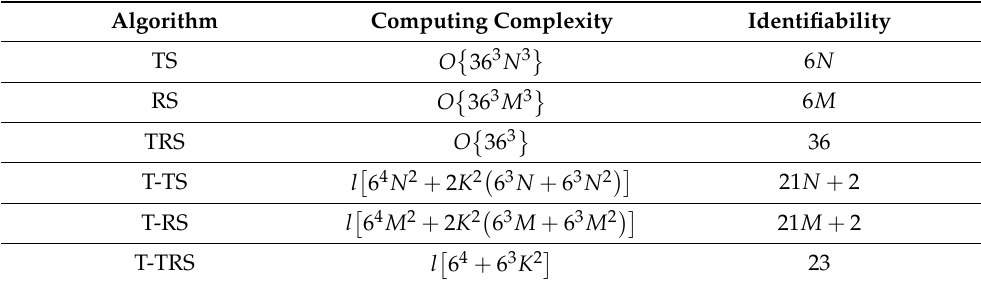
Table 1. Complexity and identifiability comparison.